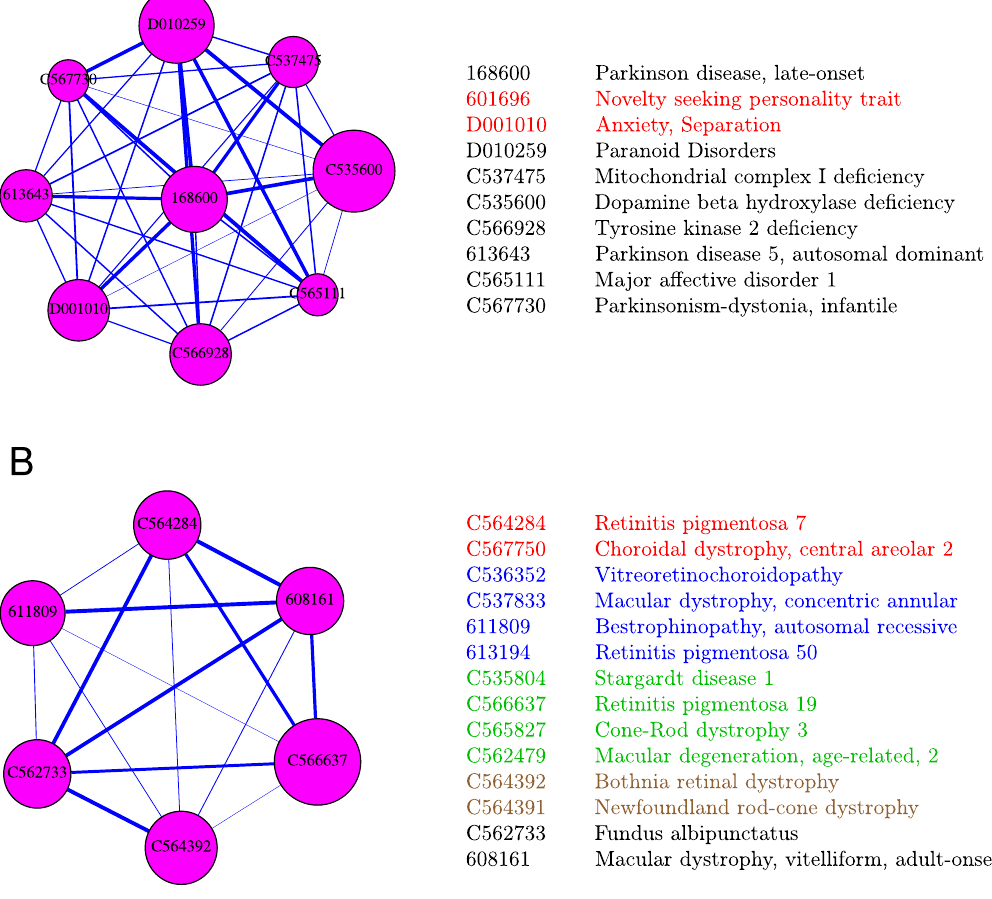
Table 4. An example of a set of diseases that are associated with the same gene, but some have different phenotypes.